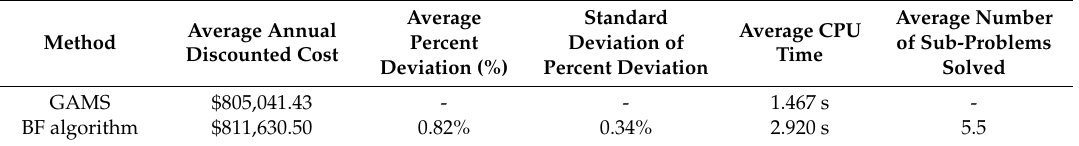
Table 7. Summary of the accuracy test results.